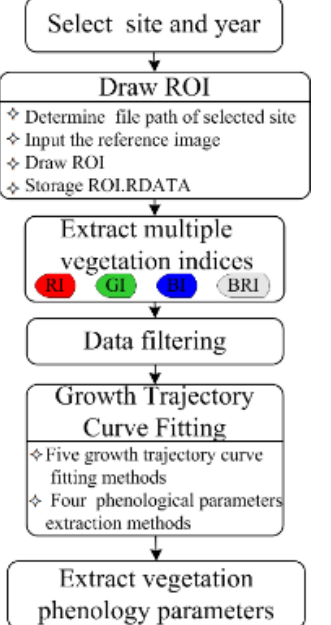
Figure 2. Flowchart of data process and phenology extraction